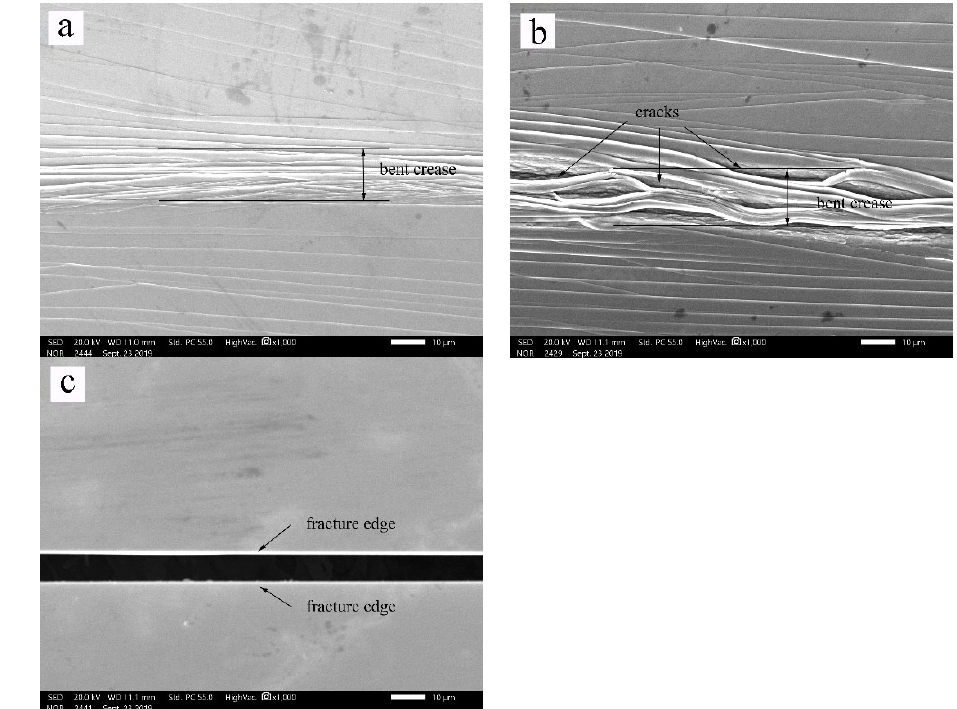
Figure 4. Shear band morphologies for amorphous alloy ribbons annealed at different temperatures: ( a ) S25; ( b ) S250; and ( c ) S380.